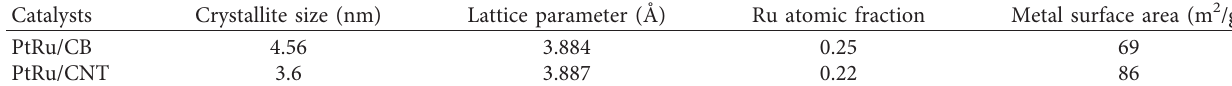
Table 1: Parameters calculated based on the XRD test.